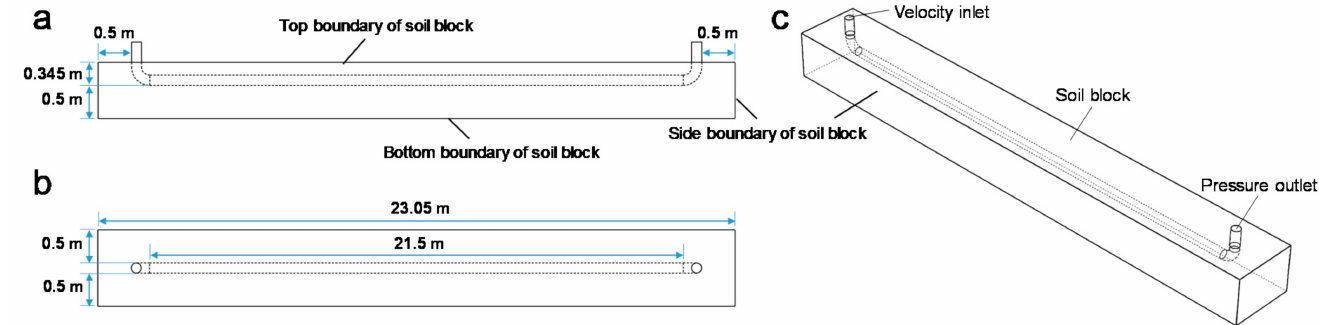
Figure 2. Schematic of the EAHE computational domain: ( a ) front view, ( b ) top view, and ( c ) perspective view.